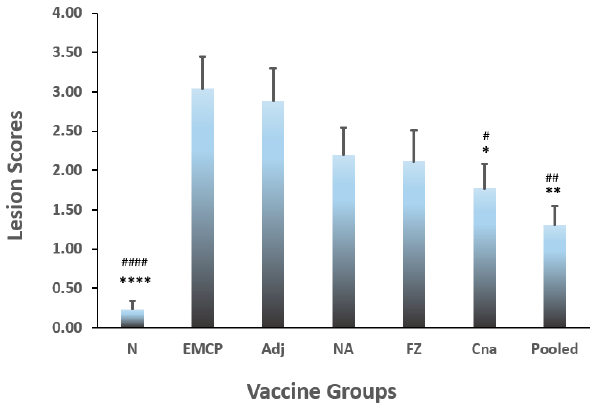
Figure 2. Lesion scores in vaccinated broiler chickens following necrotic enteritis challenge. The statistical differences were analyzed by the Kruskal–Wallis test and the Mann–Whitney U test. The chicks with 13 birds per group were immunized with recombinant proteins on Day 4 and Day 15: EMCP = positive challenge control; Adj = adjuvant + EMCP challenge; NA = chimeric NetB and Plc; FZ= chimeric FBA and Zm; Cna= collagen-binding protein; Pooled = pooled NA, FZ, and Cna antigens. The vaccinated birds were then administrated with Eimeria maxima (EM, 5 × 10 3 oocysts/bird, oral gavage) on Day 22, followed by C. perfringens (CP) netB + tpel + LLY_Tpel 17 strain (1 × 10 9 cfu /bird, oral gavage) on Day 26. Birds were sacrificed on Day 2 post-CP infection, and jejunum lesion scores were determined. The * or # marks show statistically significant difference (* p ≤ 0.05; ** p ≤ 0.01; **** p ≤ 0.0001) when compared with the value in Adj group, while # p ≤ 0.05; ## p ≤ 0.01; #### p ≤ 0.0001 when compared with the value in EMCP group, respectively).